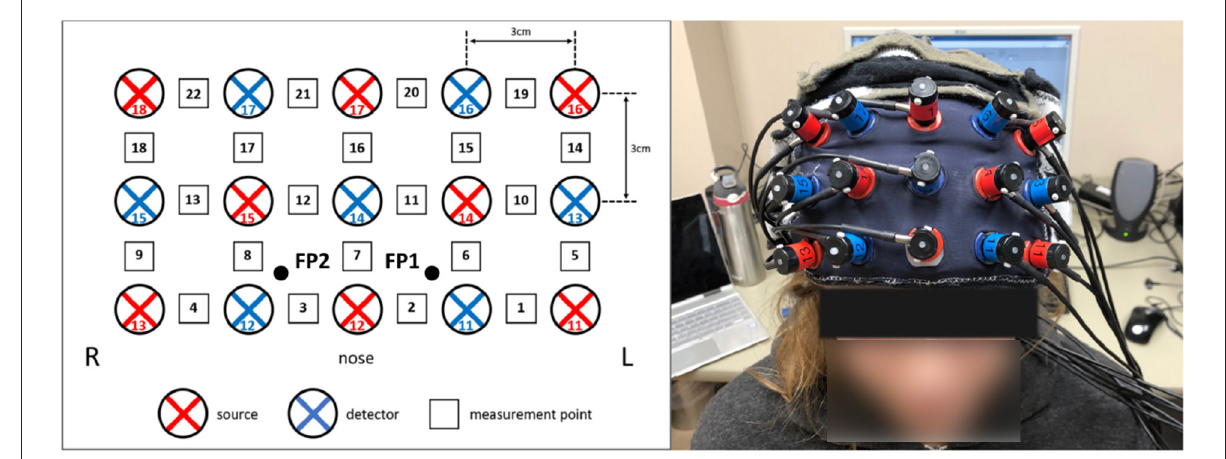
FIGURE1 fNIRS optode configuration over the prefrontal cortex. (Left) The eight light sources (red) and seven light detectors (blue) were arranged in a 3 × 5 grid over the forehead, resulting in 22 channels (black and white squares). (Right) The optodes, mounted in the headpiece and placed over the forehead.